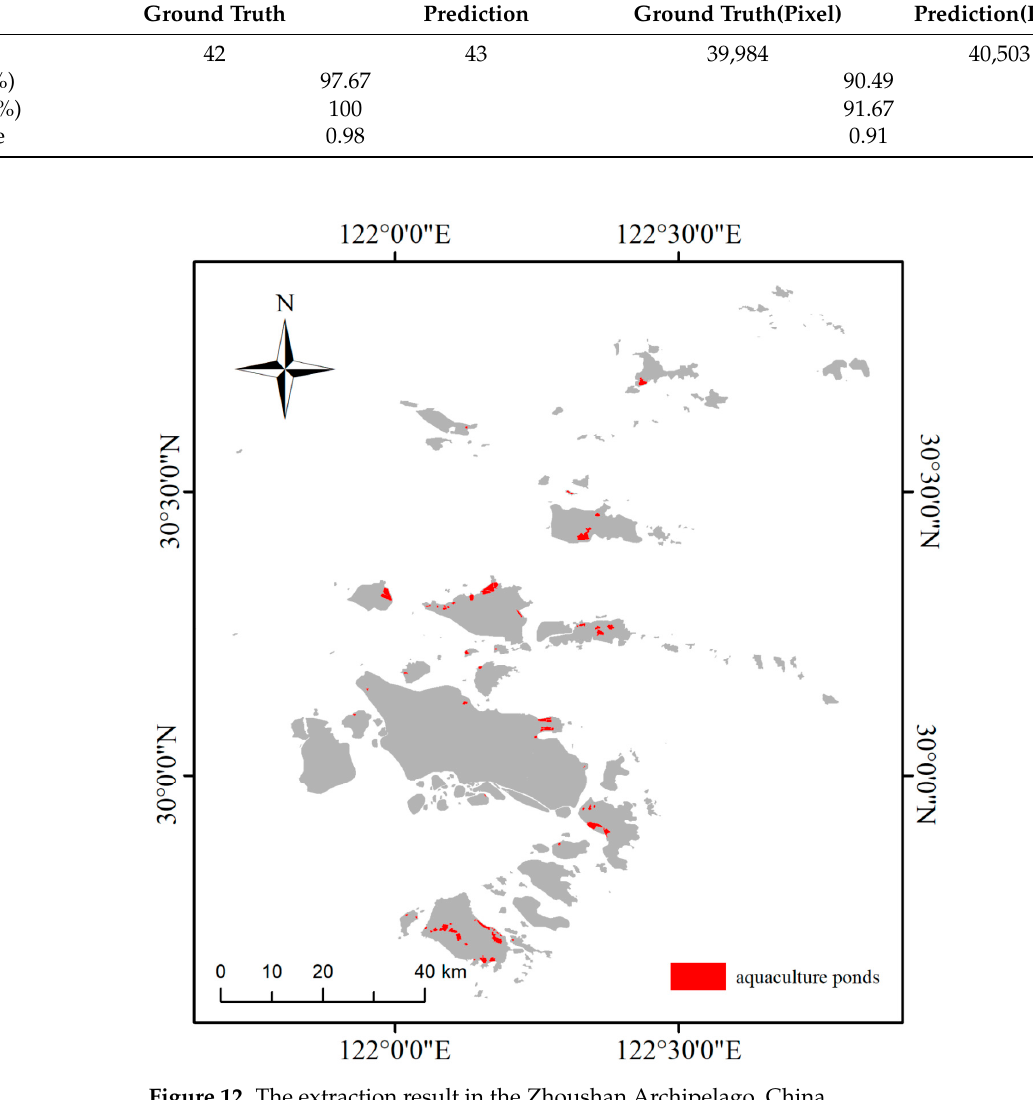
Figure 12. The extraction result in the Zhoushan Archipelago, China.